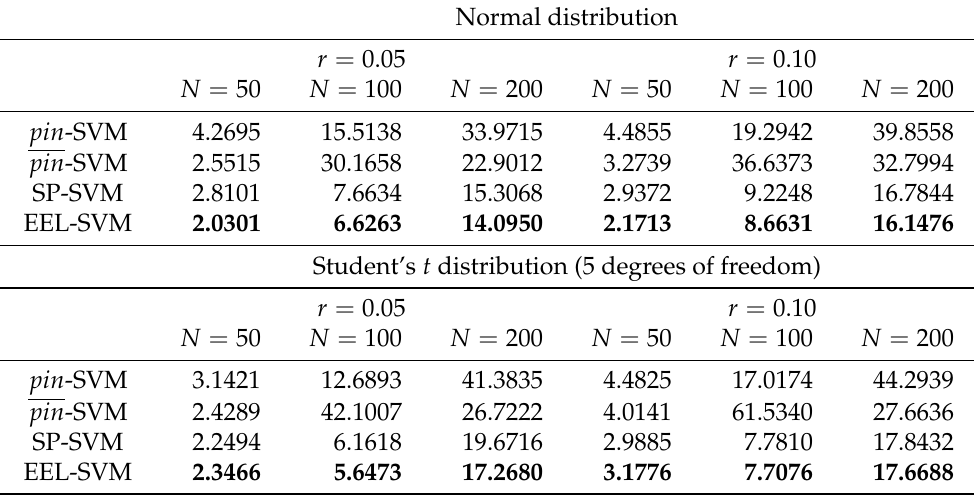
Table 3. Computational time ratios of SVM classifiers compared to C-SVM classifier for contaminated synthetic data. Lowest computational time ratio along each row in